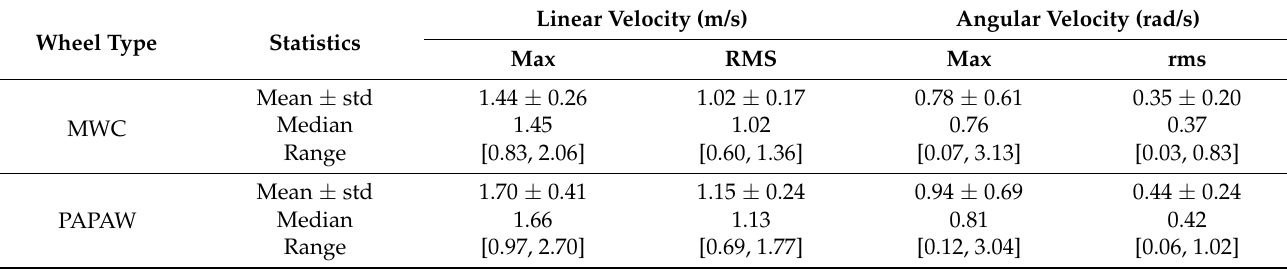
Table 6. Descriptive statistics of kinematic measurements (N = 200).